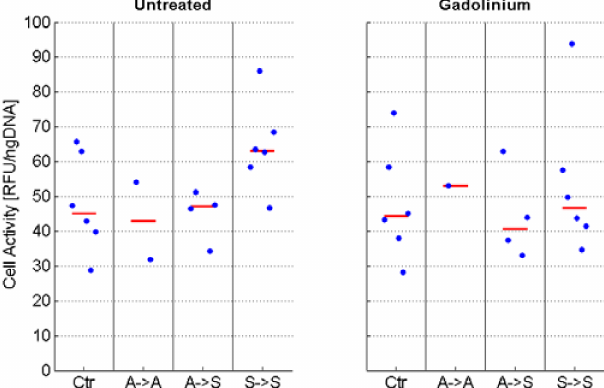
Figure 3. Cell activity. Chondrocytes were centrifuged to a pellet and incubated for three hours in resazurin containing culture medium, and fluorescence values were determined with a plate